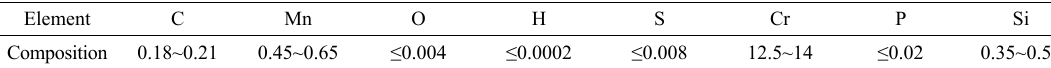
Table 1. Chemical composition of materials remelted (wt, %).